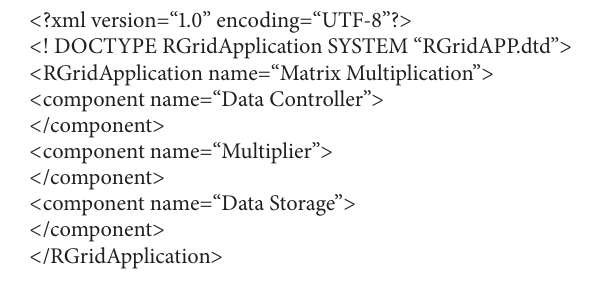
Algorithm 2: Data Controller Role